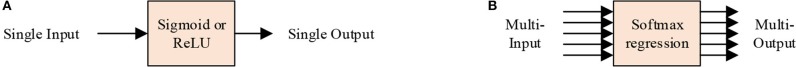
Two modes of activation function. (A) Single input single output mode. (B) Multiple input multiple output mode.